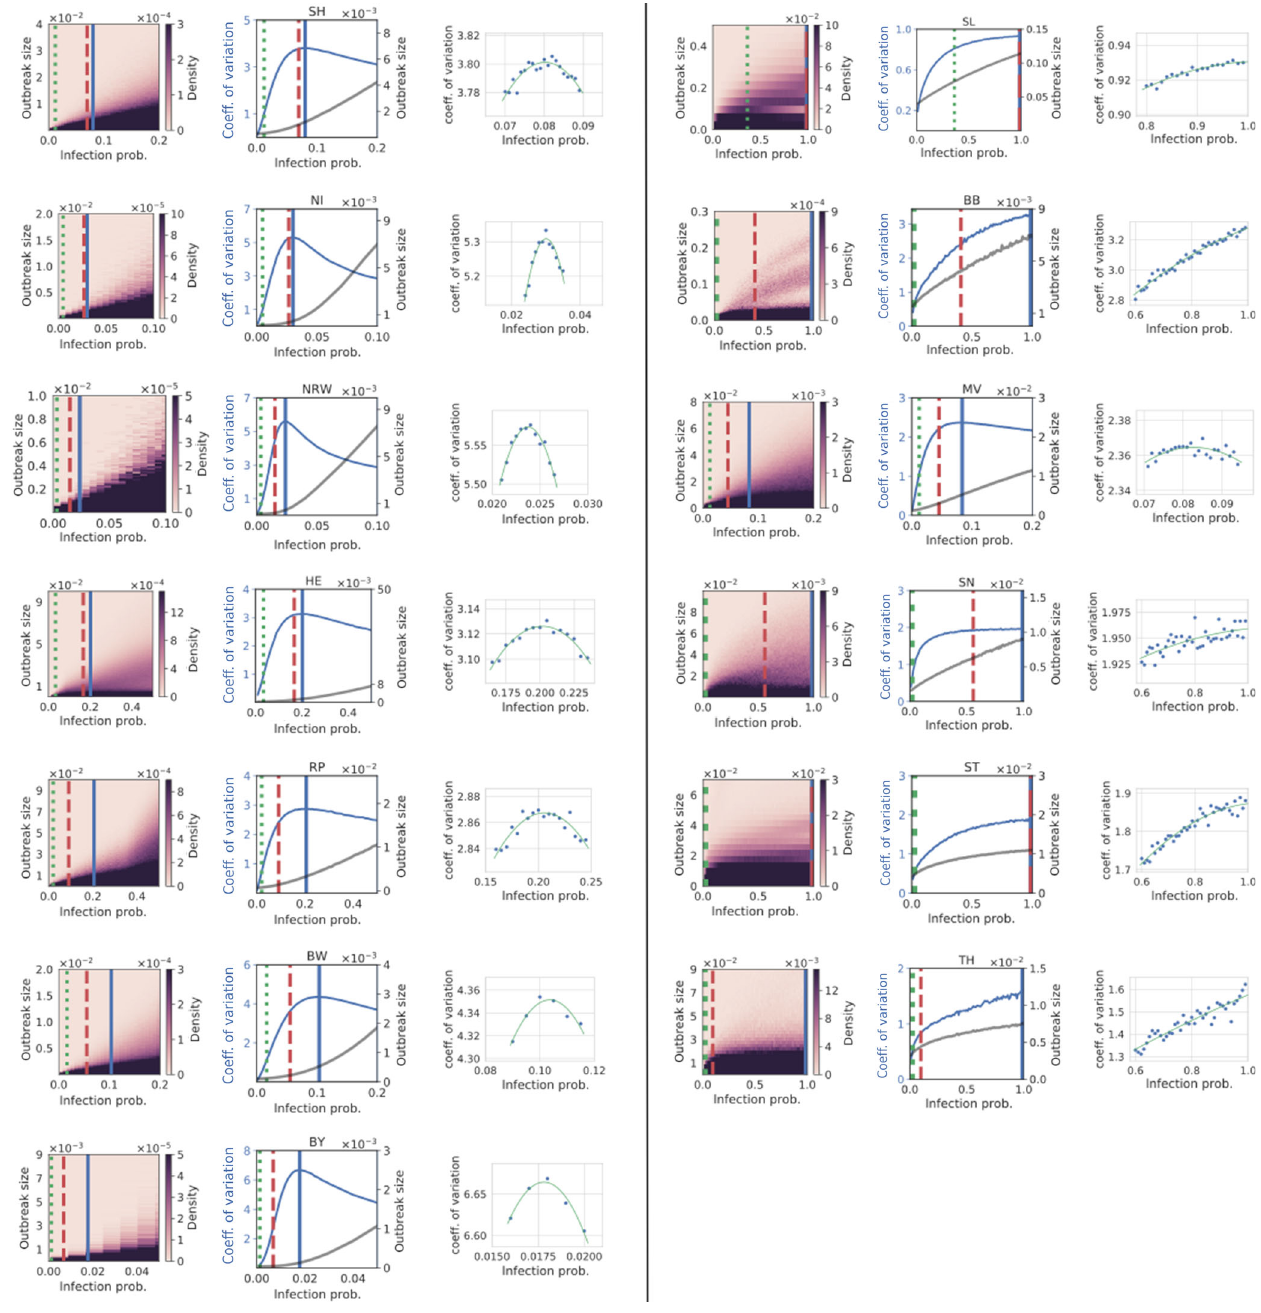
FIG. 19. Detailed analysis of the epidemic threshold for the cattle-trade network with μ ¼ 1 = 28 . The central black line separates the figure into two panels. Every row (in a panel) provides results for a single federal state in Germany, excluding the city states Berlin, Bremen, and Hamburg. Left column: Outbreak-size distribution as a function of the infection probability β . Vertical blue, red, and green lines mark the critical infection probability according to MC simulations, and the CB and IB models, respectively. Middle column: Coefficient of variation c v (blue line, left axis), mean outbreak size (green dashed line, right axis). Right column: Selected values of c v for infection probabilities close to the critical value. The quadratic fit (green line) estimates the maximum and hence β